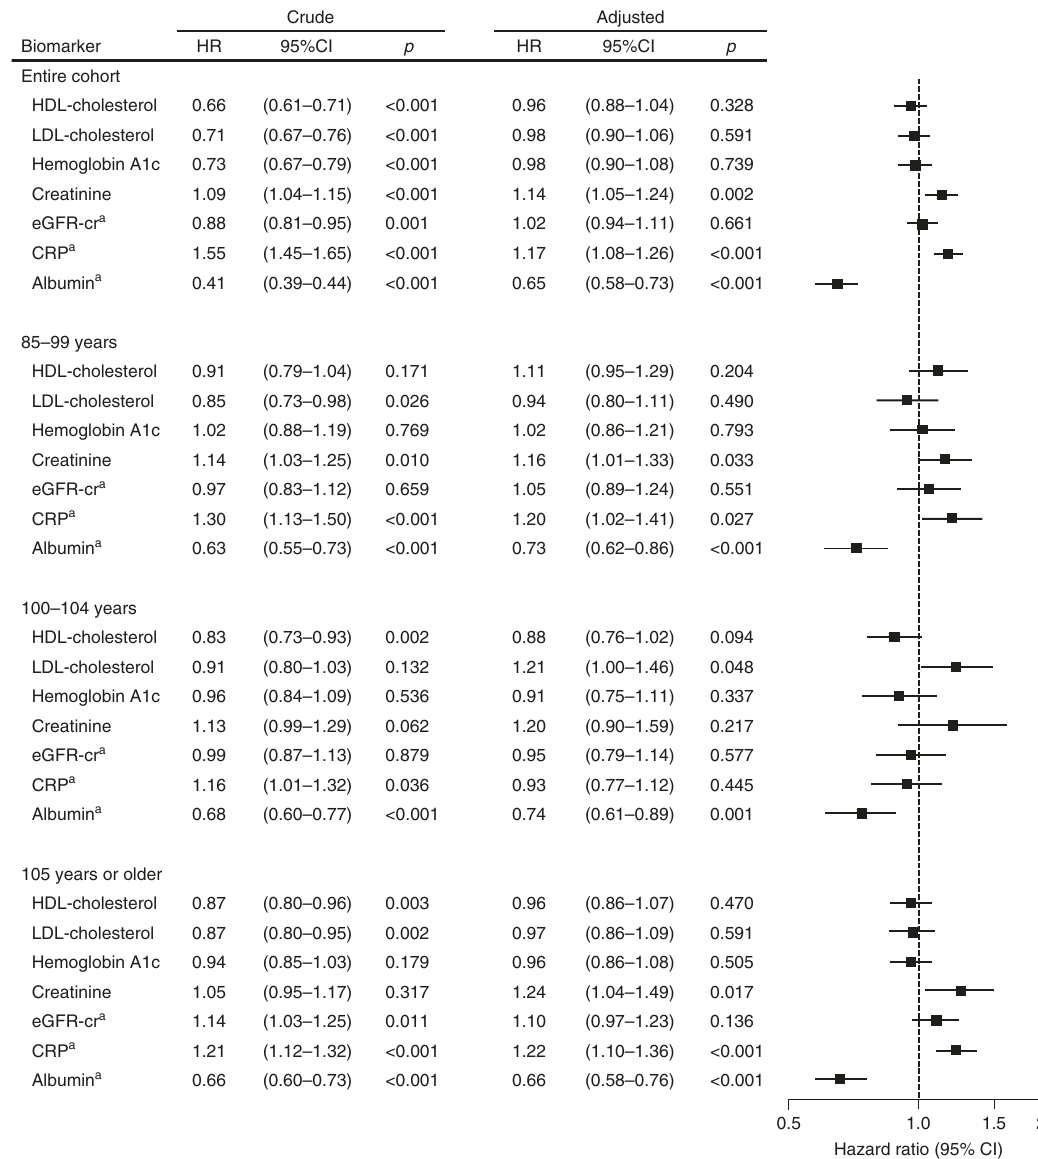
Fig. 5 Hazard ratios for death from any causes according to traditional cardiovascular risk factors and albumin. Hazard ratios (HRs) and 95% con fi dence intervals (CIs) were calculated with the use of univariate and multivariate Cox proportional hazard models for the entire cohort, those aged 85 – 99 years at enrollment, 100 – 104 years at enrollment, and 105 years or older at enrollment. Because the number of individuals aged 110 years or older was too small for multiple analyses, this age group was included in the group over 105 years old. Multivariate analyses were adjusted for the base model covariates; sex, age, educational status, current smoking, history of cardiovascular disease, hypertension, hyperlipidemia, diabetes mellitus, chronic kidney disease (stage 3b-5), CRP ( ≥ 0.3 mg/dL), major ECG abnormality, cardiovascular medications, and low plasma albumin (<3.5 g/dL). Each risk factor (continuous variable) was entered independently into the models and hazard ratios for each risk factor are reported per 1 SD increment except CRP (1 SD increment in natural log-transformed values for CRP). Hyperlipidemia was excluded from the base model for associations of HDL or LDL cholesterol levels with mortality, and diabetes mellitus was excluded for association of hemoglobin A1c with mortality. A forest plot shows multivariate-adjusted hazard ratio (squares) and 95% con fi dence interval (horizontal lines). Two-sided P values were calculated from Cox proportional hazard models. a eGFR-cr, CRP and albumin were entered into the base model as continuous variables instead of categorical variables. HDL indicates high-density lipoprotein, LDL low-density lipoprotein, eGFR-cr estimated glomerular fi ltration rate based on plasma